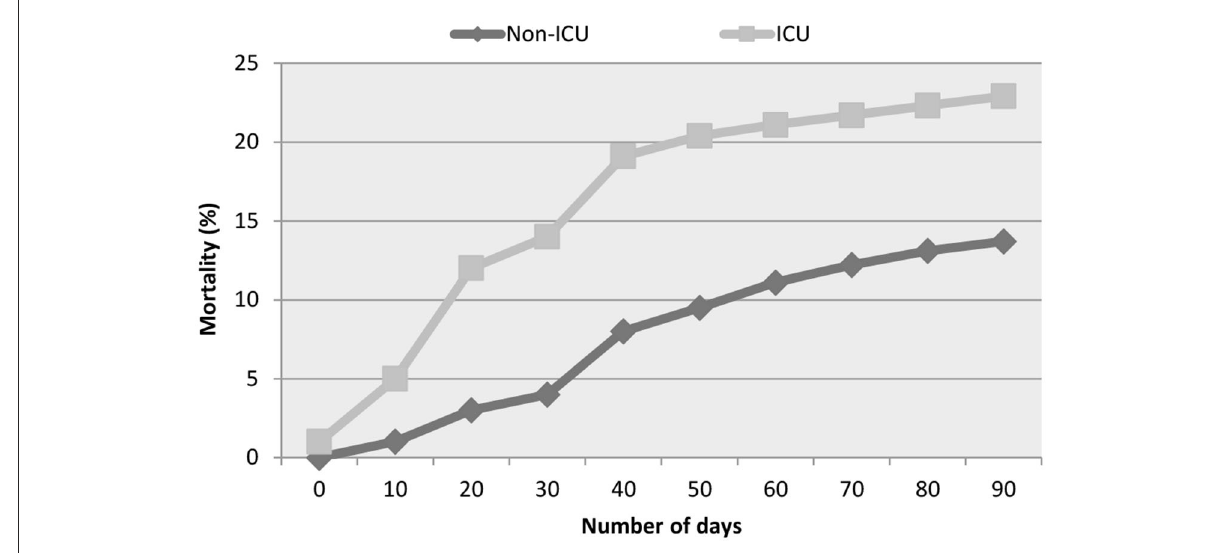
FIGURE1 All-cause mortality recorded in COVID-19